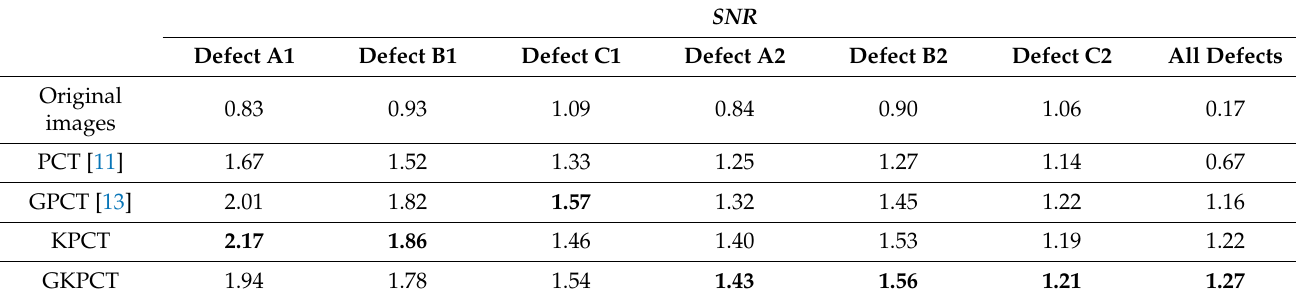
Table 2. SNR values of different methods for CFRP specimen 2.